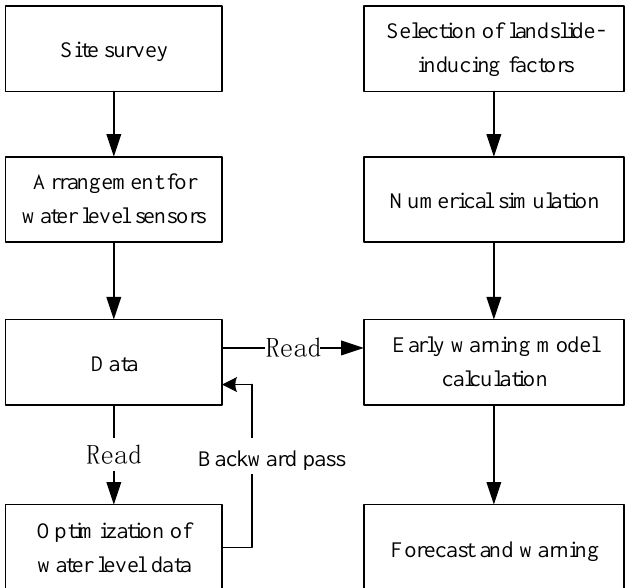
Figure 2. Operation flow chart of landslide warning system on the basis of the online monitoring of water level.